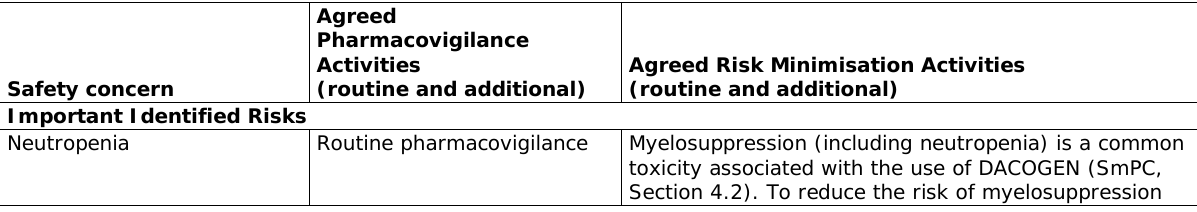
Table 22: Summary of the risk management